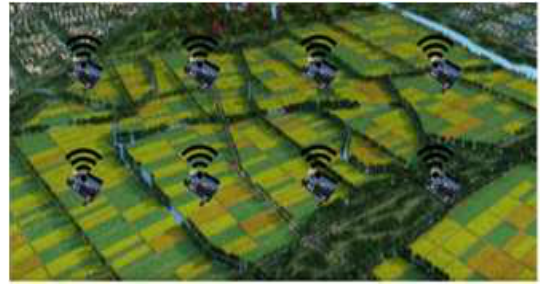
Figure 6. Multiple LoRa devices are deployed in farmland.